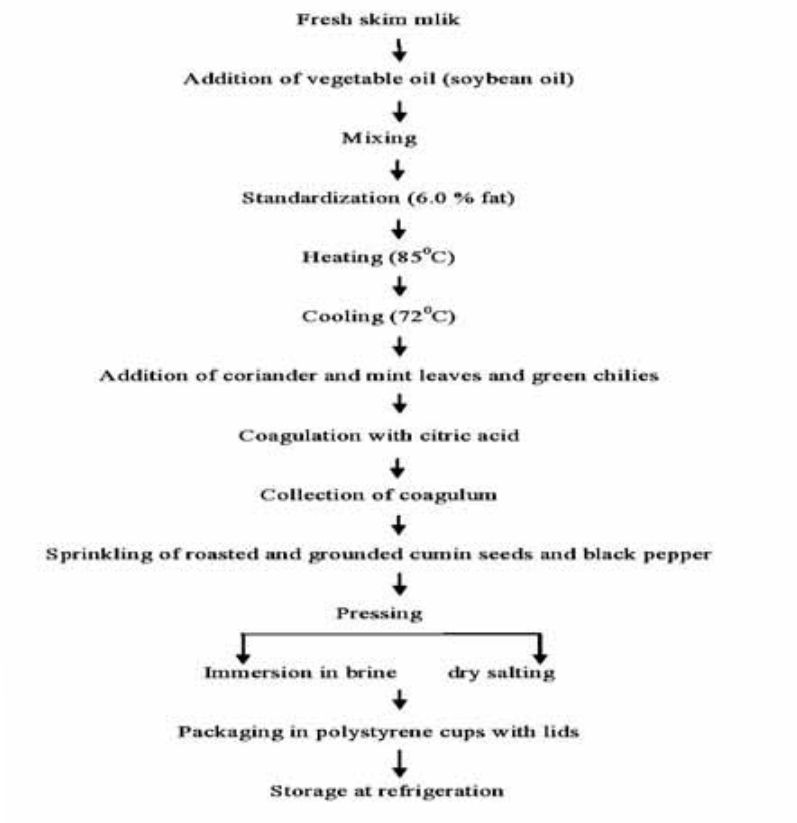
Figure-1: Flow chart for ready-to-serve low cholesterol masala